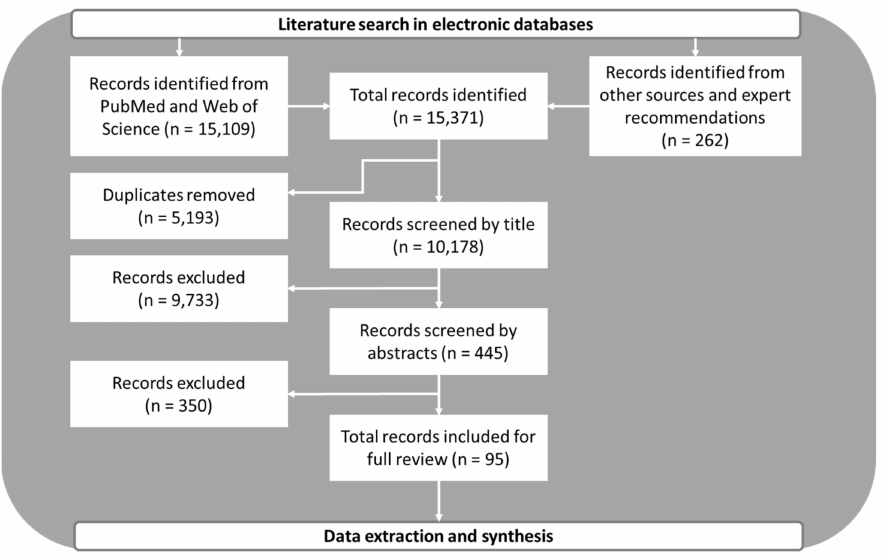
Figure 1. Flowchart of literature search